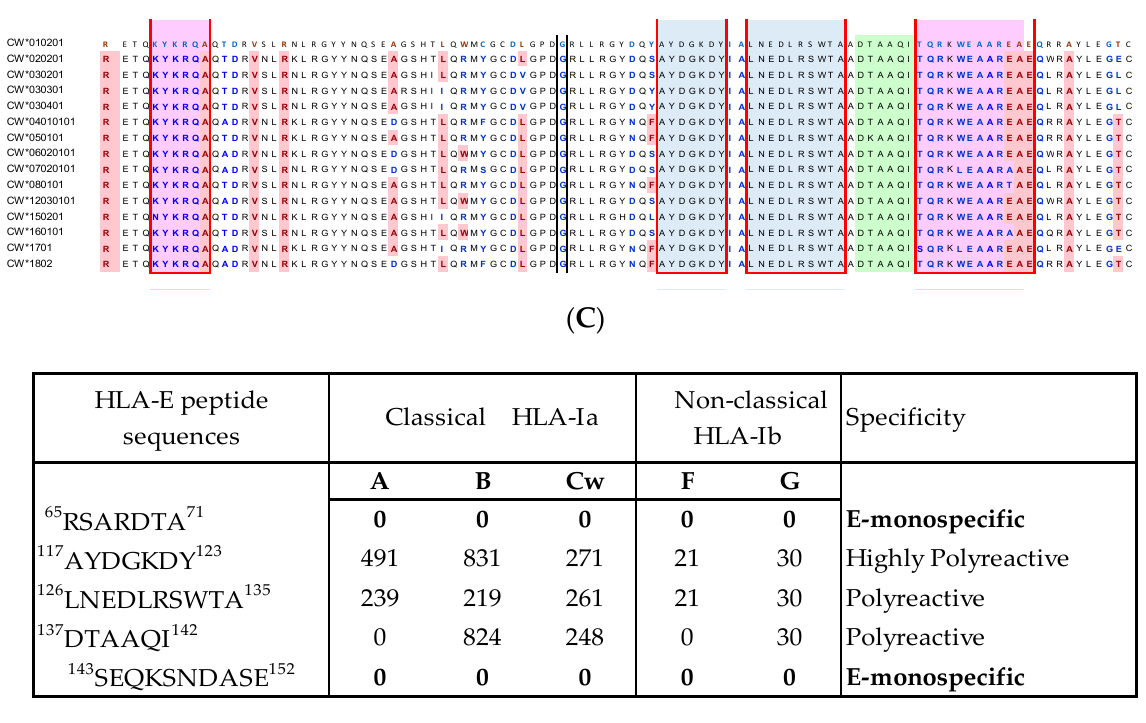
Figure 2. Comparative profile of the amino acid sequences of HLA-Ia alleles (HLA-A, HLA-B, and HLA-C) and HLA-Ib (HLA-E, HLA-F, and HLA-G) isoforms: HLA-Ia and HLA-Ib shared sequences and HLA-Ib and HLA-Band HLA-C shared sequences coated on the microbeads of LABScreen beadsets. ( A ) HLA-E,-F,-G compared with 30 alleles HLA-A coated on the LABScreen beadset; ( B ) 58 alleles HLA-B coated on the LABScreen beadset; ( C ) 15 alleles HLA-C coated on the LABScreen beadset; and ( D ) HLA-E amino acid sequences shared with HLA-Ia and HLA-Ib alleles. To further confirm the monospecificity, we carried out dosimetric inhibition of puri- fied culture supernatants of TFL-033 with two HLA-E-restricted peptides, 65 RSARDTA 71 and 143 SEQKSNDASE 152 , at concentrations ranging from 4.4 to 0.27 mg/well. Although